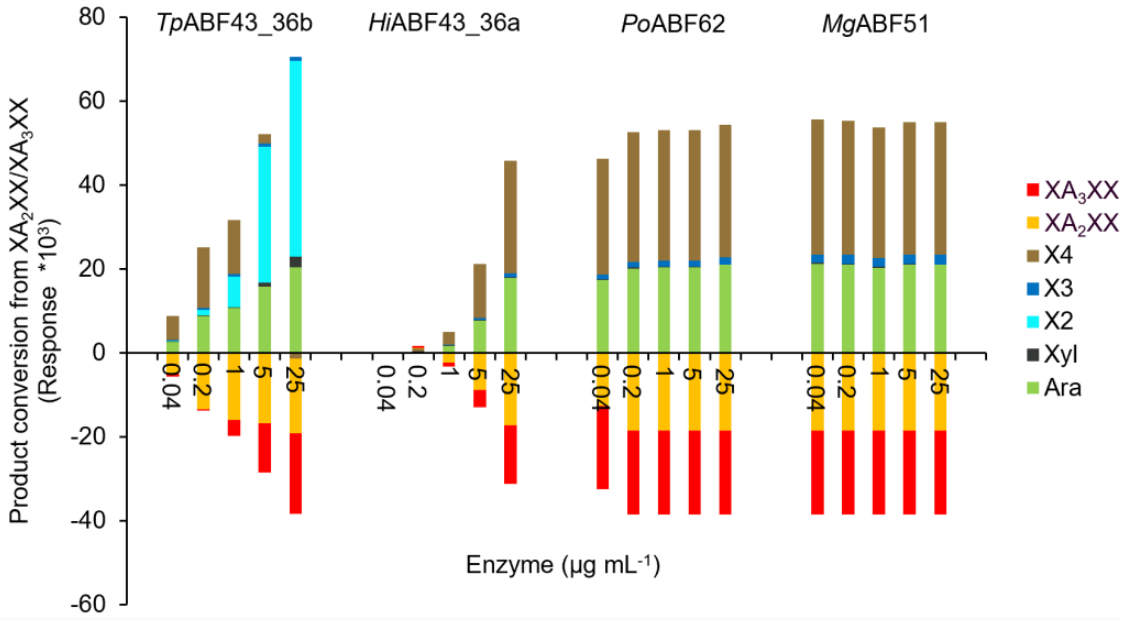
Figure 11. XA 2 XX/XA 3 XX product conversion (HPAEC) when incubated with Hi ABF43_36a, Tp ABF43_36b, Po ABF62, and Mg ABF51. Arabinose (Ara), xylose (Xyl), XOS (DP 2 to 4), XA 2 XX, and XA 3 XX were detected. Reaction conditions are displayed in Section 4.2.2, exp. # 2.